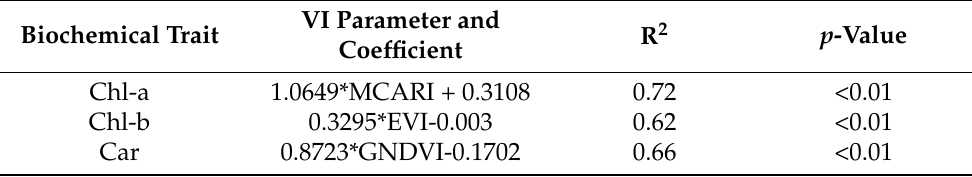
Table 2. Biochemicals traits regressions resulted from the best and significant performing vegetation indices (Chl-a from MCARI; Chl-b from EVI; Car from GNDVI). Coefficient of determination (R 2 ) and significance ( p -value) for the regressions are specified.